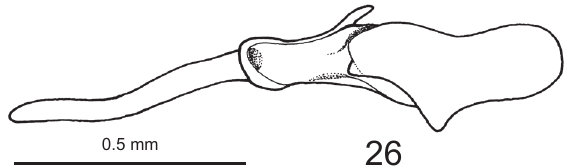
Figure 26. Pampsilota nigeriae : Penis valve (left, lateral